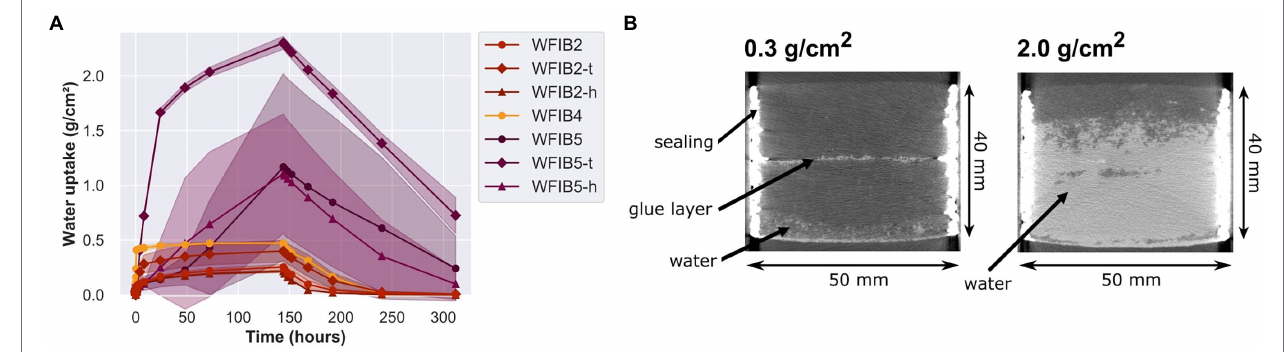
FIGURE 9 | (A) Mean liquid water uptake (g/cm 2 ) with standard deviation over 144 h of absorption and 168 h of desorption in a floating test. Comparison of wood fibre insulation boards made using the wet manufacturing process (WFIB2, WFIB4 and WFIB5). Specimens were laid atop the water surface with the densified bottom side, without ( − ) or with a hole (h) or with the undensified top (t) in contact with the water surface; (B) Difference in water absorption between a wood fibre insulation board type 5 (WFIB5) specimen which had absorbed 0.3 g/cm 2 and a specimen which had absorbed 2.0 g/cm 2 after 144 h of absorption. X-ray CT scan taken after 144 h of absorption and 1 h of